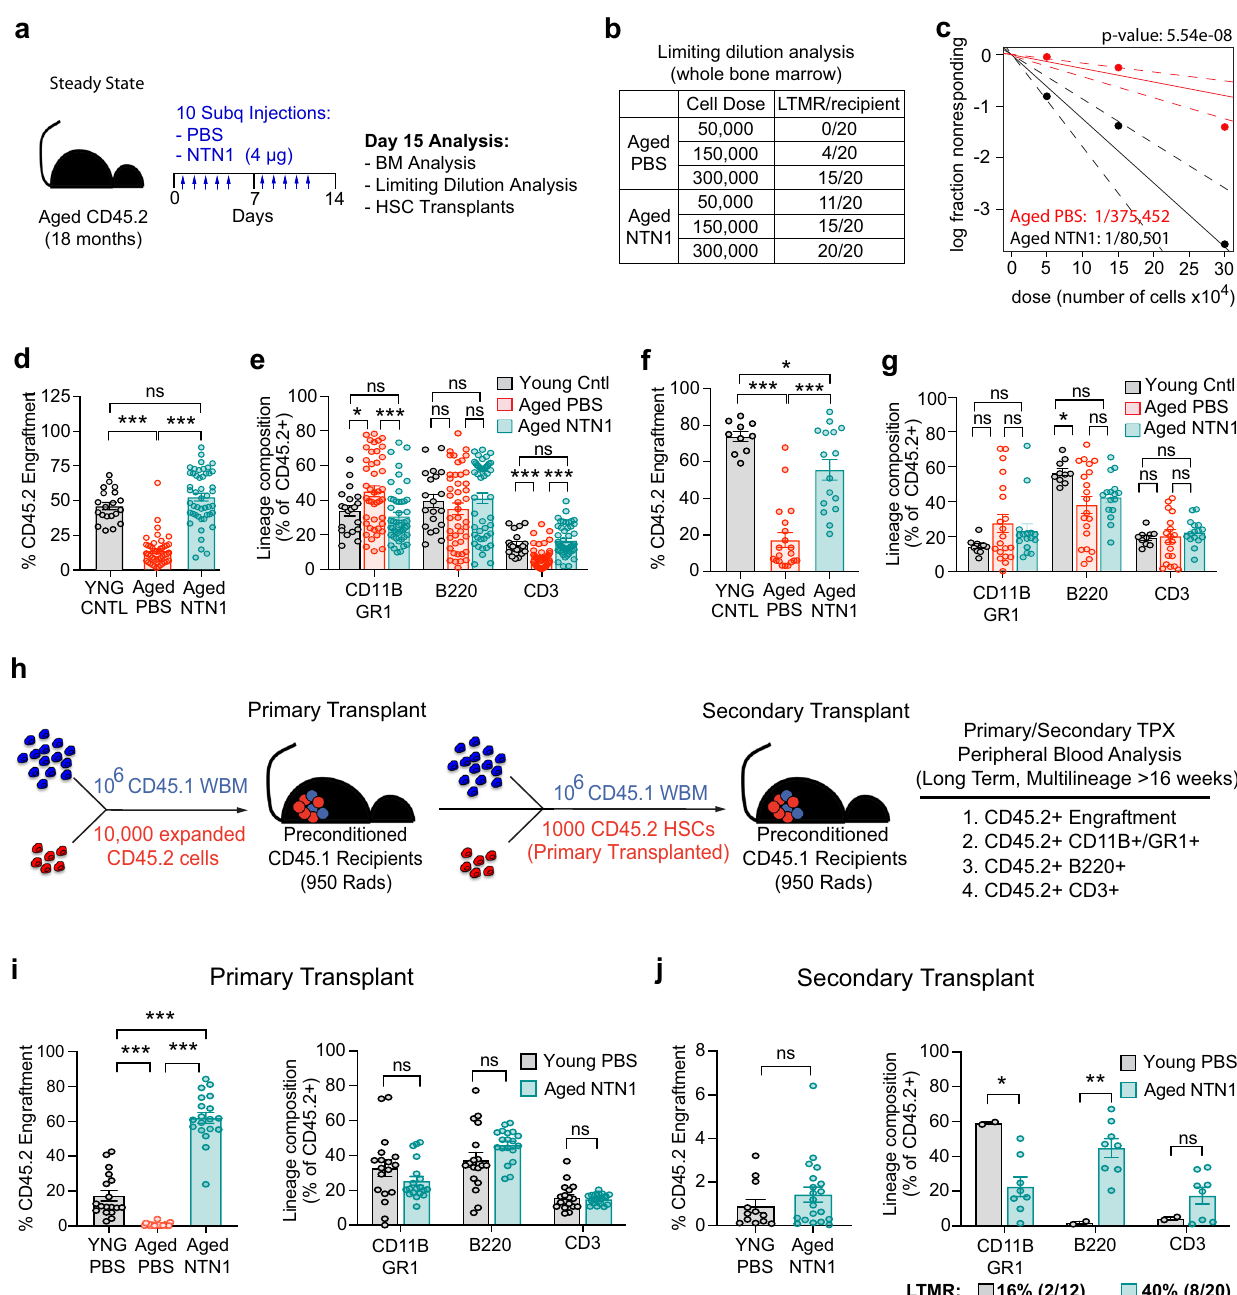
Fig.8|NTN1rejuvenatesagedHSCfunctionality.a ExperimentaldesignforNTN1 treatment in steady state aged mice. b , c Limiting dilution WBM transplantation analysis demonstrating ~4 fold increase in HSC numbers in aged mice treated with NTN1 as compared to PBS treated aged mice, evaluated by number of recipient mice demonstrating long-term multi-lineage reconstitution (LTMR) in their per- ipheral blood after 16 weeks following transplantation ( N =3 donors/group; N